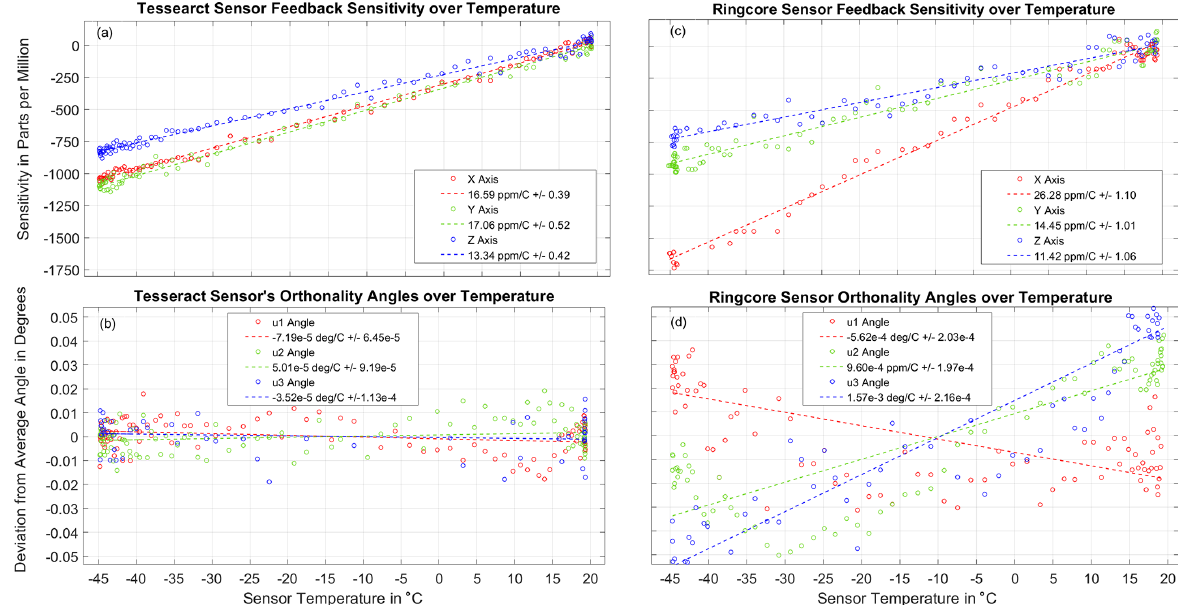
Figure 12. (a) The measured sensitivity of the Tesseract sensor’s three feedback windings plotted against temperature. Each circle is a 2min measurement of the amplitude of the 60000nT, 23Hz signal. The dotted lines are a robust linear fit to the data. The fits estimate the Tesseract sensitivity over temperature. (b) The Tesseract sensor’s three orthogonality angles, u 1 , u 2 , and u 3 , plotted as a function of sensor temperature. None of the angles are found to unambiguously skew by more than 0.015 ◦ . (c) The measured sensitivity of the Miles et al. (2013) ring-core sensor’s three feedback windings plotted against temperature. (d) The Miles et al. (2013) ring-core sensors’ orthogonality angles are found to skew over temperature by as much as 0.09 ◦